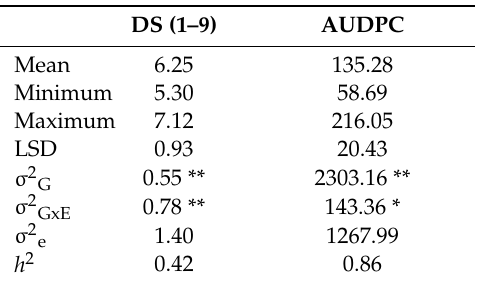
Table 1. Mean, range, and variance components for disease severity (DS) and AUDPC for maize inbred line association mapping panel